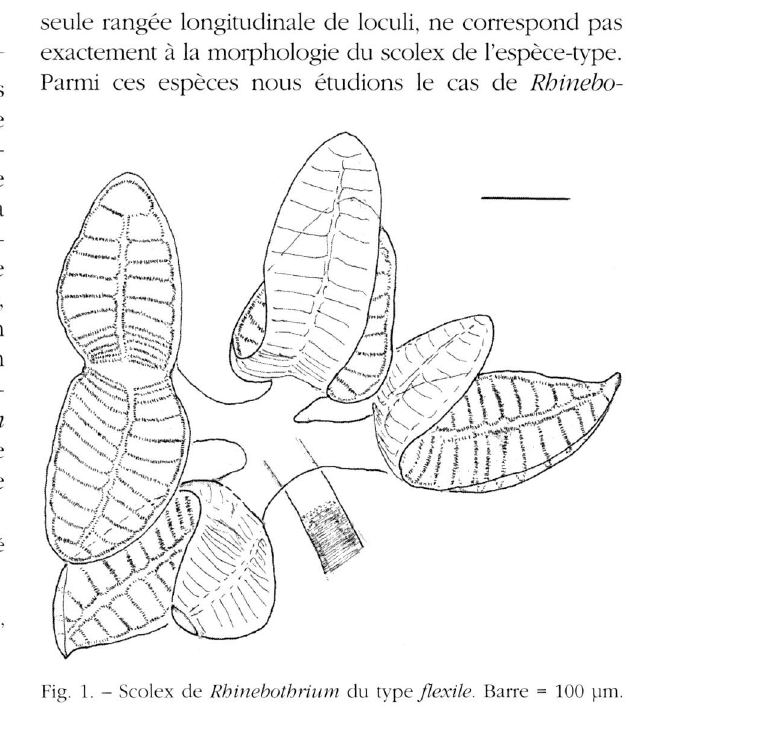
Fig. 1. - Scolex de Rhinebothrium du type flexile. Barre = 100